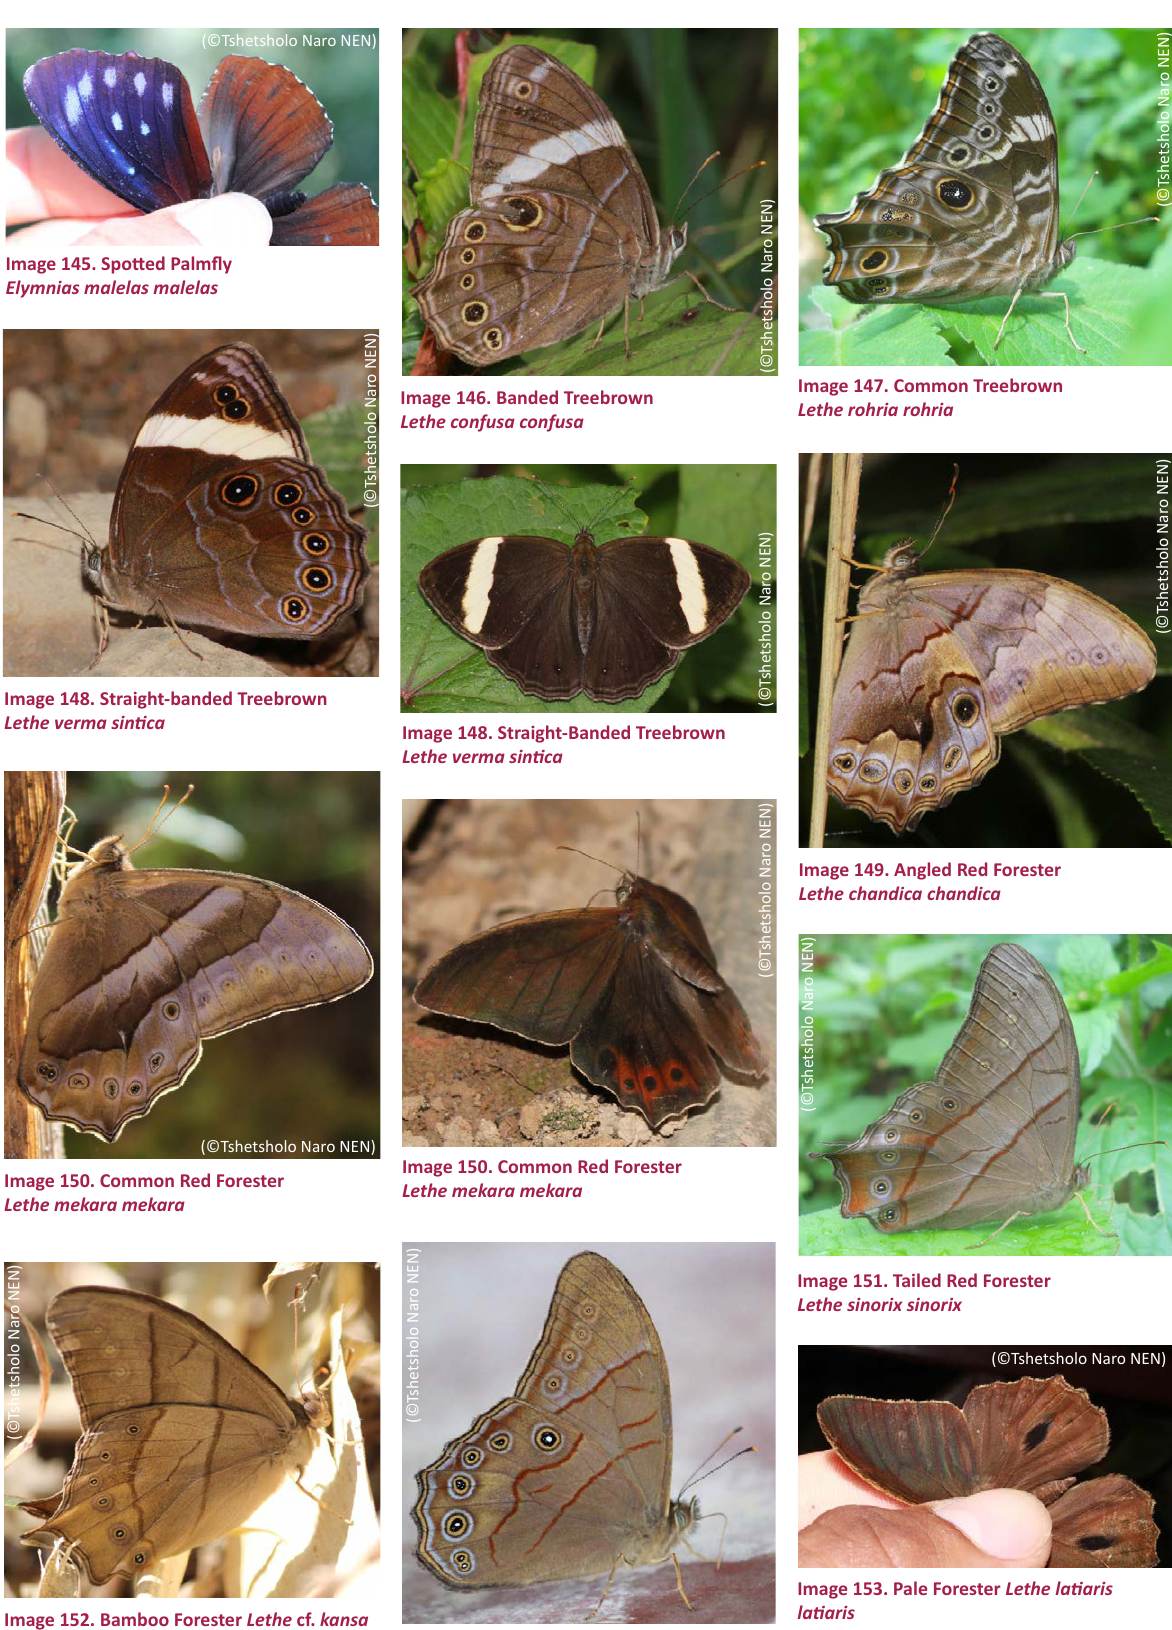
Image 153. Pale Forester Lethe latiaris latiaris